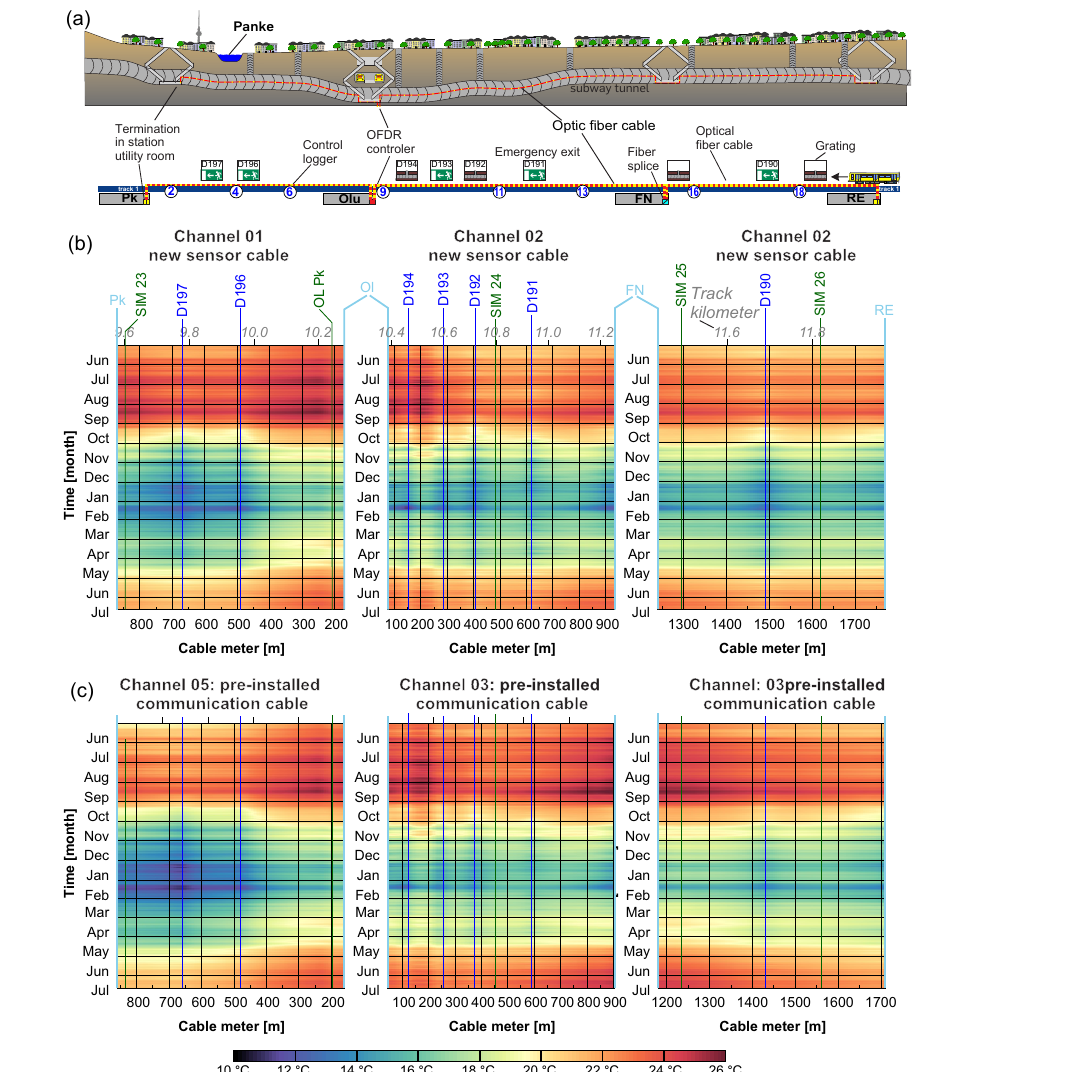
Figure 2. Setup of measurements, (a) recorded daily mean temperatures by new sensor cables, (b) and pre-installed communication cables (c) between June 2016 and February 2017. The observed temperatures of the new sensor cable and the pre-installed communication cable are very similar. Cold spots are clearly associated with the emergency exits and gratings. Channels 1 and 6 show a relatively cool tunnel section at about 650 and 700m, which is related to the above flowing river Panke. Between 100 and 200m a warm section was observed in Channels 2 and 3, which is exactly the location of siding tracks, where trains park during off-peak and cause additional heat transfer. Inside the station, the cable tray is located underneath the platforms (cooler areas) and inside utility rooms (warmer areas).